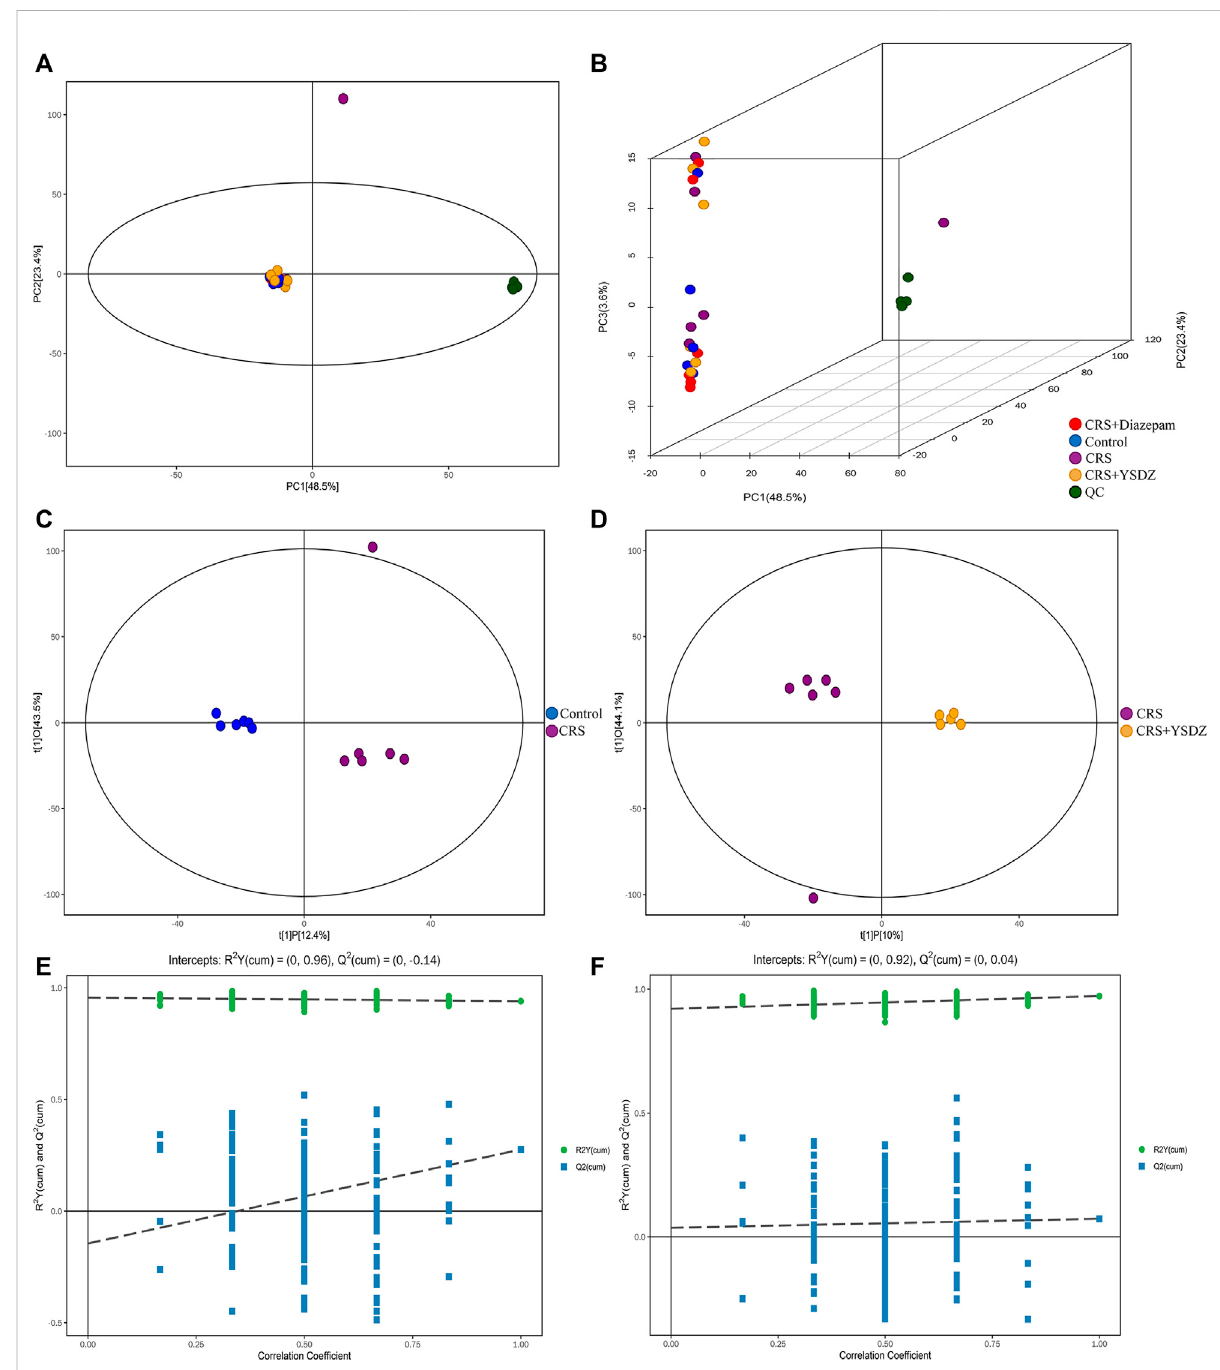
FIGURE 10 Multivariate statistical analysis of metabolites. (A) Score scatter plot of the PCA model; (B) 3D Score scatter plot of the PCA model. QC (quality control), n = 6 per group. (C,D) are score scatter plot of the OPLS-DA model. (C) is CRS vs. Control. (D) is CRS + YSDZ vs. CRS. (E,F) are permutation plot test of the OPLS-DA model. (E) is CRS vs. Control. (F) is CRS + YSDZ vs.